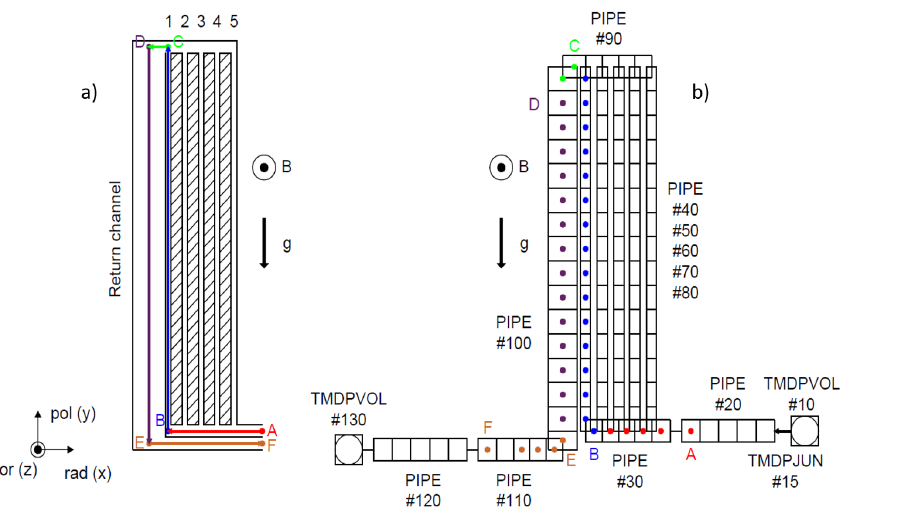
Figure 10. ( a ) 2D scheme of the LLCB TBM. Shaded area represents the breeding modules. ( b ) Nodal- ization of the